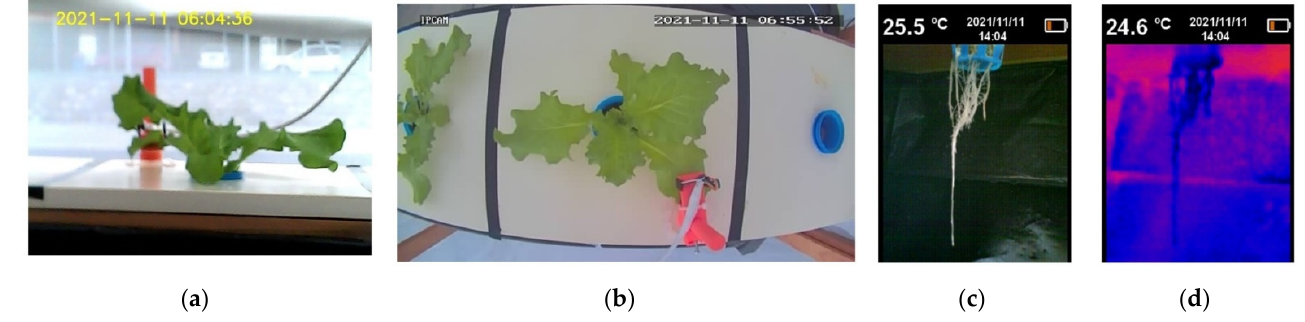
Figure 10. Images acquired by the proposed intelligent monitoring system. ( a ) Lateral view of the crop; ( b ) top view of the crop; ( c ) RGB image of the root; ( d ) thermographic image of the root.